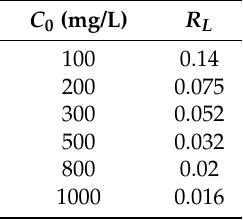
Table 3. Langmuir equilibrium constants RL at various initial